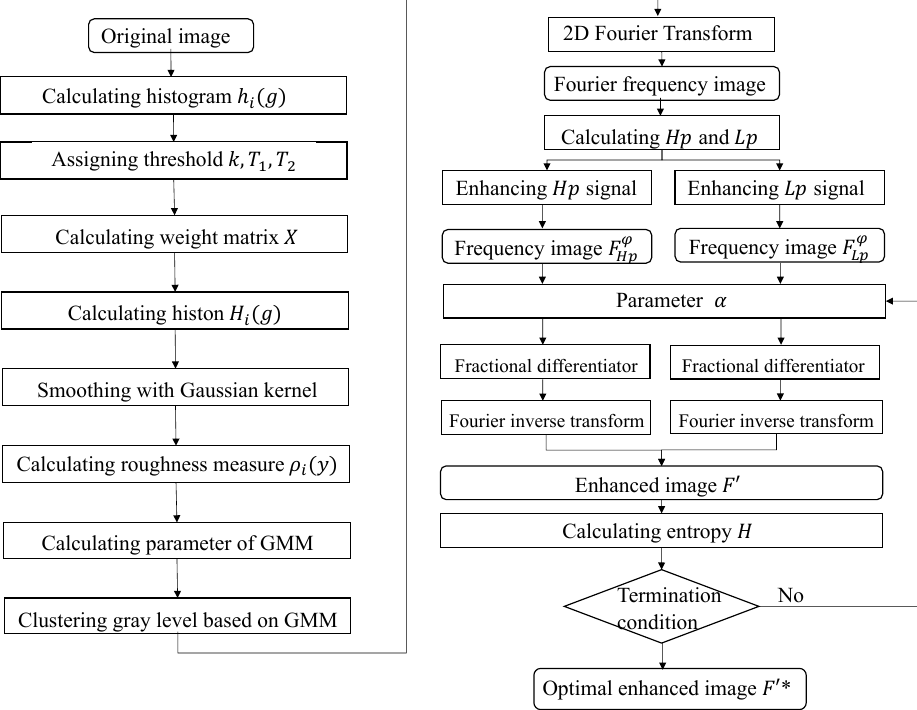
Figure 9. The process of the proposed algorithm where F (cid:48) ∗ denotes the optimal